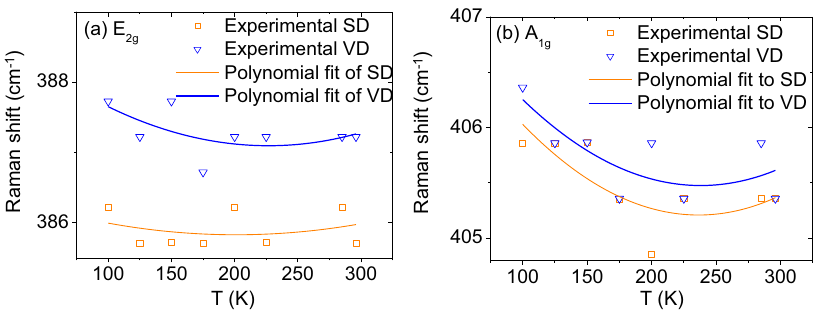
Fig. 6 Temperature coef fi cient of Raman modes. Temperature-dependent Raman shift of the a in-plane E 2g and b out-of-plane A 1g modes of virgin (VD) and stressed (SD) CVD monolayer MoS 2 channel. Polynomial fi t to the experimental data, shown here, is used to extract the fi rst-order temperature coef fi cient and Raman shift at absolute zero temperature for both the characteristic modes of monolayer MoS 2 . Discussed, in detail, in Supplementary